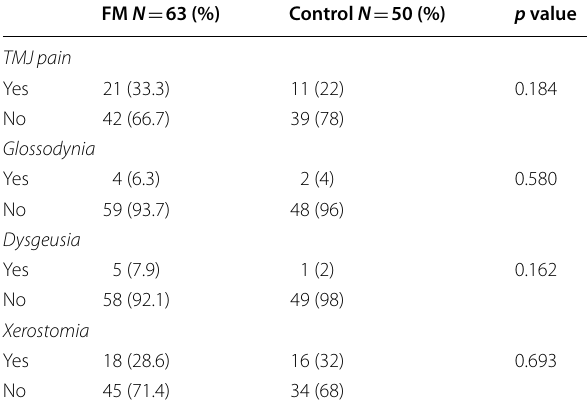
Table 2 The frequency of orofacial symptoms and the comparison results between the